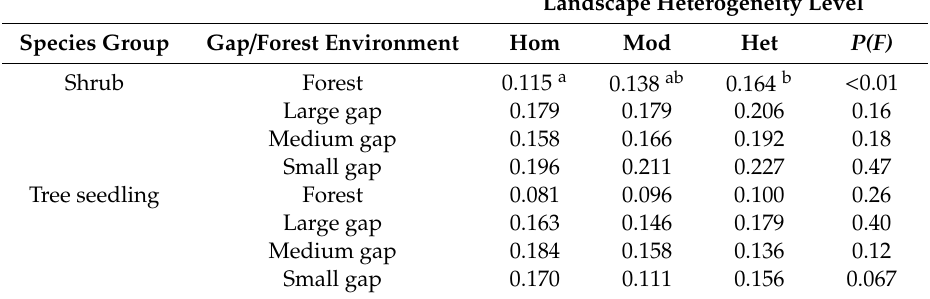
Table 5. Comparison of multivariate dispersion as measured by the mean distance to spatial median for shrubs and tree seedling species groups in landscapes of di ff erent heterogeneity levels (heterogeneous (Het), moderate (Mod), homogenous (Hom)) for di ff erent gap / forest environments. Values